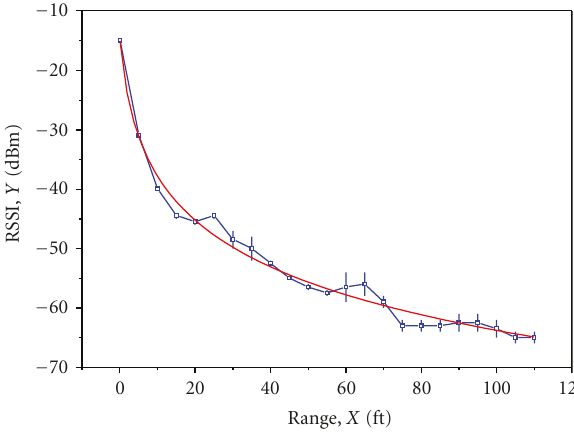
Figure 9: Schematic of node distinguishment process within one hop.